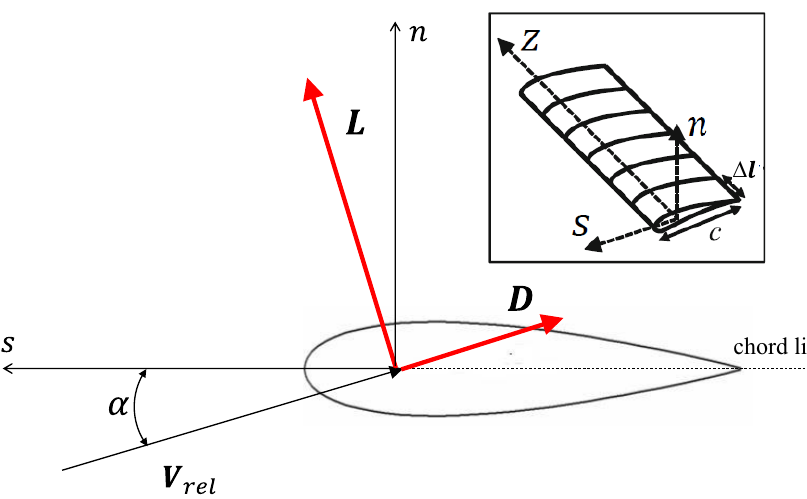
Figure 2. Diagram of forces acting on the